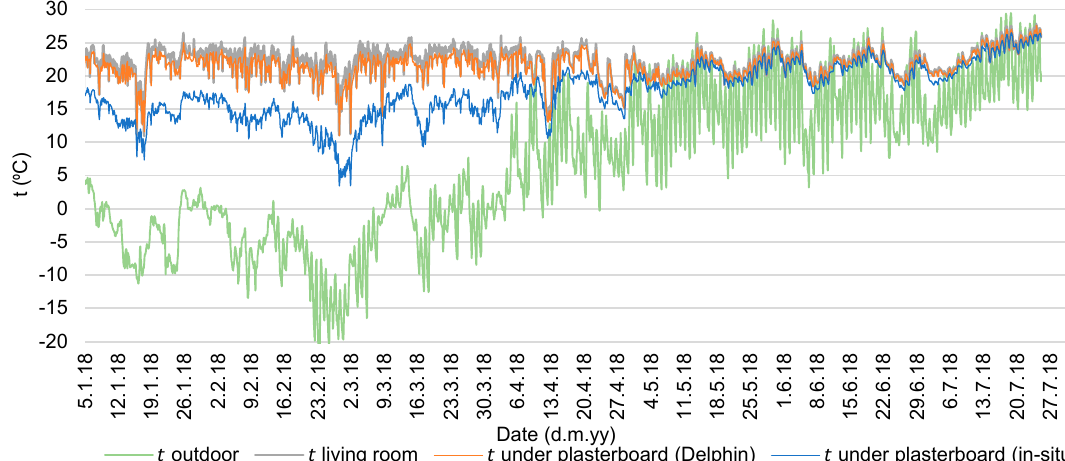
Figure 13. The temperature of the living room wall between the insulation and vapor barrier: measured T (blue line), simulated T (orange line), indoor T (grey line), and outdoor T (green line). RH under the insulation mostly stays between 60 and 80%. Measured RH exceeded 90% in March during the water leakage incident when RH between the dolomite wall and insulation layer rapidly increased to 100% and then slowly dried out during the spring and summer (see Figure 14).